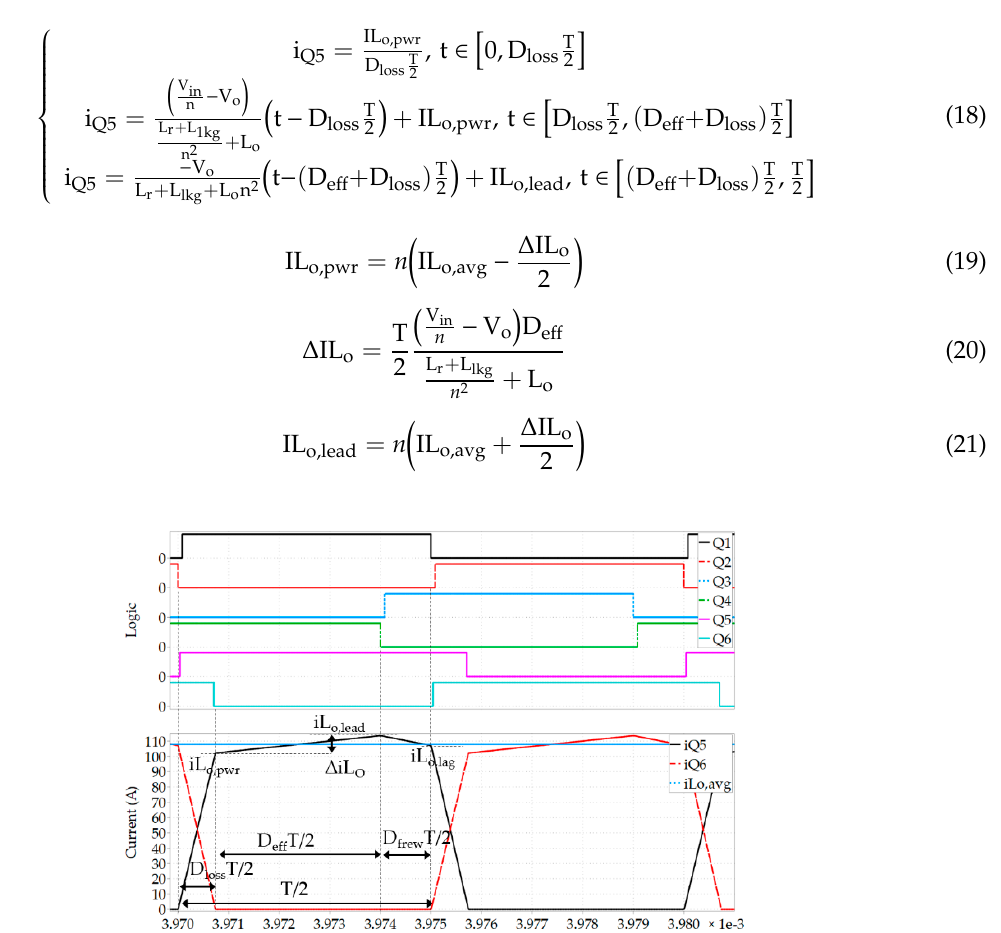
Figure 4. Secondary side LV MOSFETs current and PWM control signals of a simplified model of a PSFB converter.